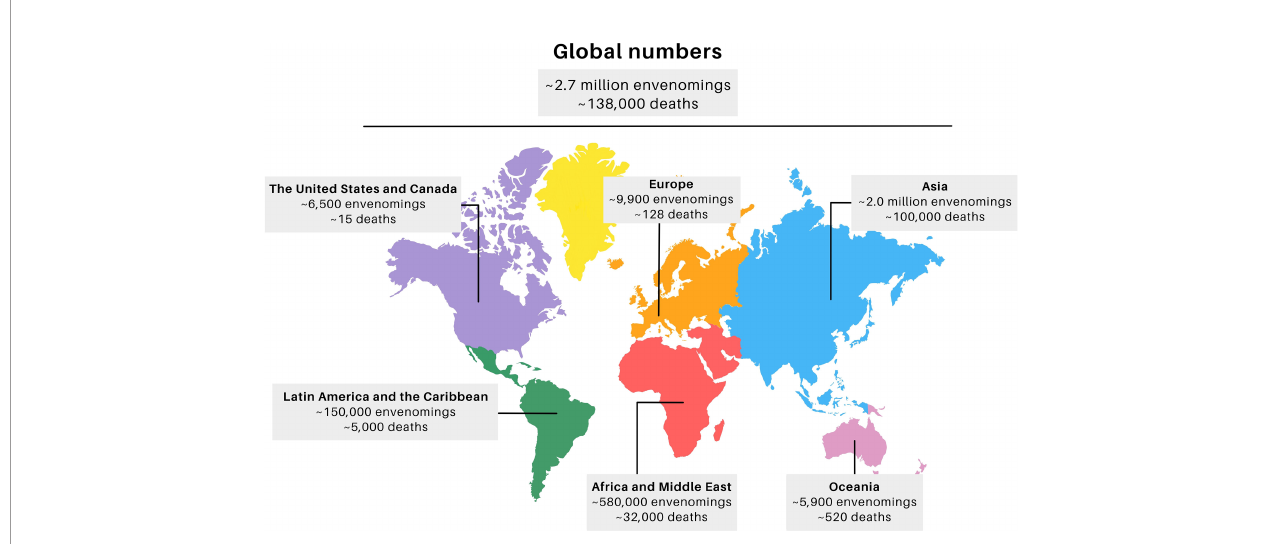
FIGURE 1 | Global distribution of snakebite cases. Adapted from J.M. Gutiérrez et al. (2017) Ref. (6) The fi nal fi gure was prepared using